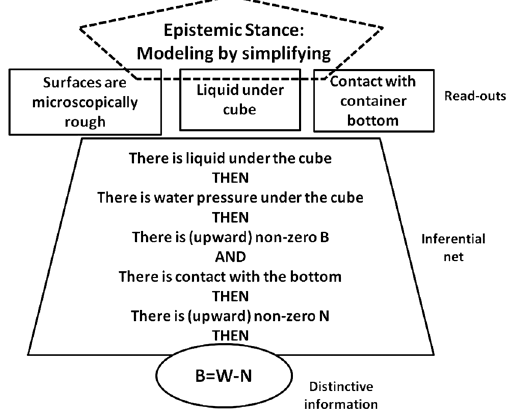
FIG. 8. Schematic diagram of projection described in S 4